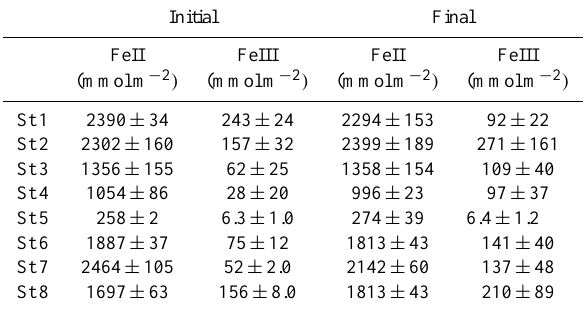
Table 3. Initial and final depth-integrated pools (0–20cm) of FeIII ± SE ( n = 3) at St 1–8. t tests showed no significant differ- ence between initial and final FeIII pools at any